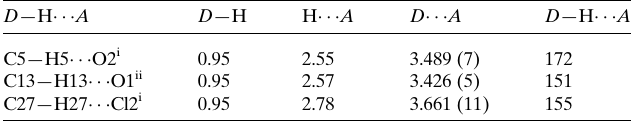
Table 1 Hydrogen-bond geometry (A˚ , (cid:2)